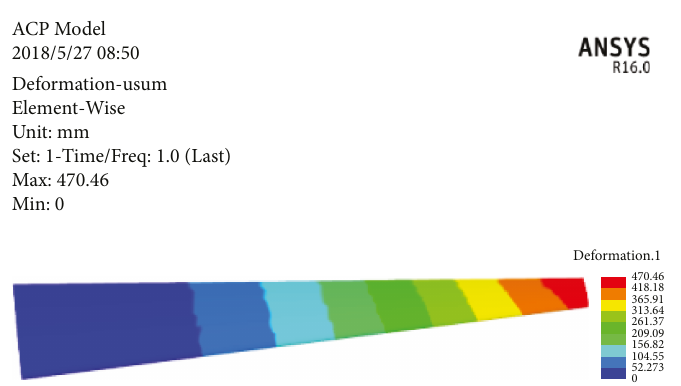
Figure 38: Deformation cloud diagram with the layer angle being ± 45 and 90.